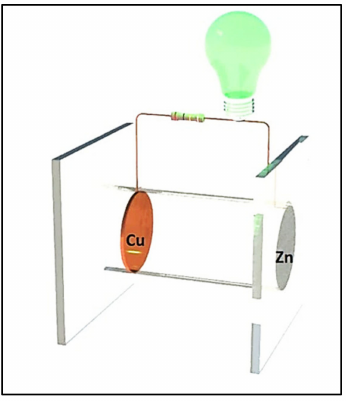
Figure 1. Scheme of the MFC